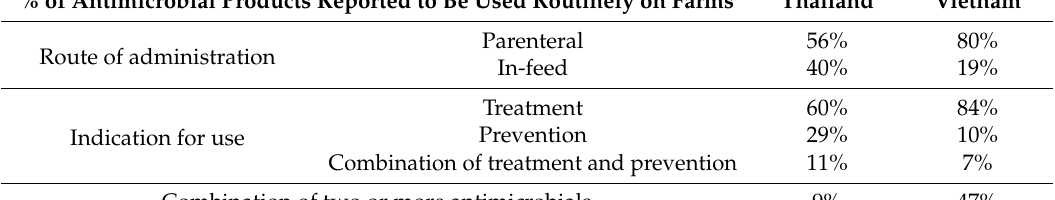
Table 7. Characteristics of antimicrobials used in a case study in antimicrobial use in pig production in Thailand and Vietnam.